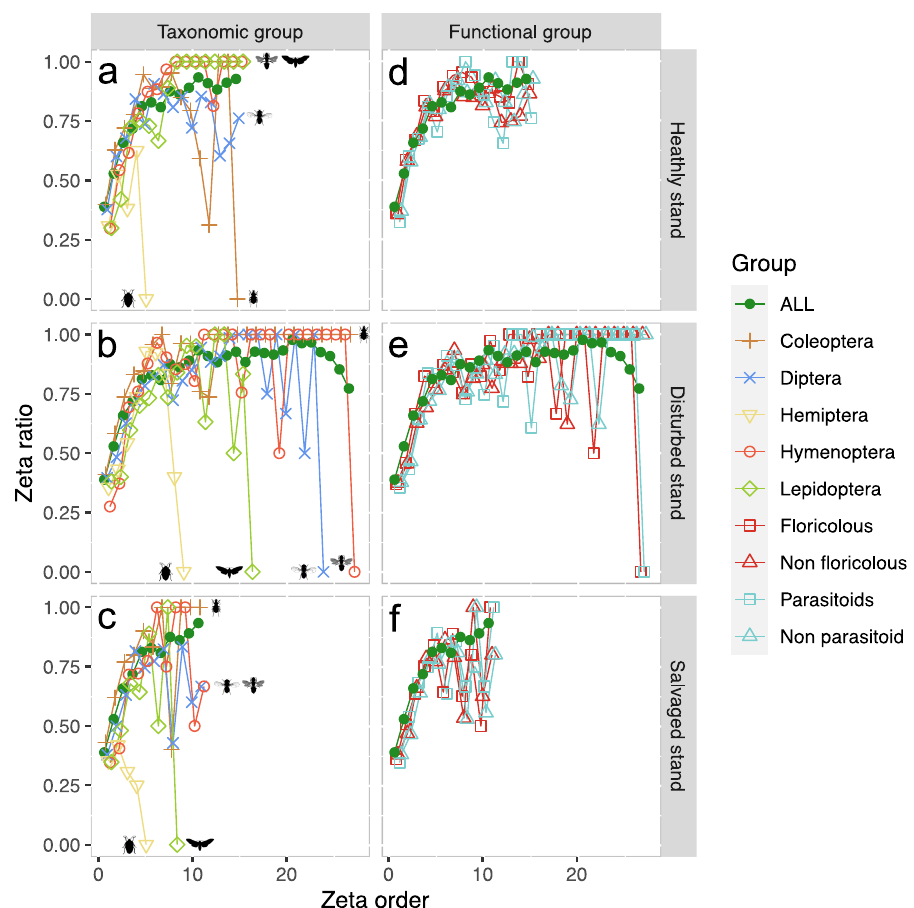
Fig. 7 Effect of stand type on community composition for insect orders and functions. Representation of the species retention rate (i.e. zeta ratio) per plot (i.e. zeta order) following nearest-neighbour plot combinations scheme (NN) with parameter sample set to 5000 and Monte – Carlo (mc) sampling for healthy, disturbed and salvaged stands, respectively, a – c for the fi ve main insect Orders (Coleoptera, Diptera, Hemiptera, Hymenoptera and Lepidoptera) and d – f for the four main ecological functions recovered from taxonomic assignment ( fl oricolous/non- fl oricolous and parasitoid/non-parasitoid species). Green line with plain dots represents mean species retention rate of the total dataset in each respective dieback category. Increasing curves express that common MOTUs are more likely to be retained in additional samples than rare ones (with the presence of common species over all plots if zeta ratio = 1) and decreasing curves indicate species turnover. In the present case, we found no core of common species for Hemiptera within each studied stand type. For clarity purposes, Hemiptera are hereafter not considered. Within healthy stands, only Coleoptera had no common species retained, while Diptera had a slight drop in the probability of common species occurring, but yet not a complete compositional turnover. Lepidoptera, Diptera and Hymenoptera were all impacted by disturbed stands with complete compositional turnovers within studied plots, and similar observation could be noticed for parasitoid and fl oricolous functional assemblages. Meanwhile, Coleoptera had a constant core of common species across the considered plots, and similar observation could be made within salvaged plots. Again, Lepidoptera assemblages were fully heterogenous across salvaged-logged plots, and both Diptera and Hymenoptera expressed a lower probability of sampling common species, but yet not showing a complete change in community